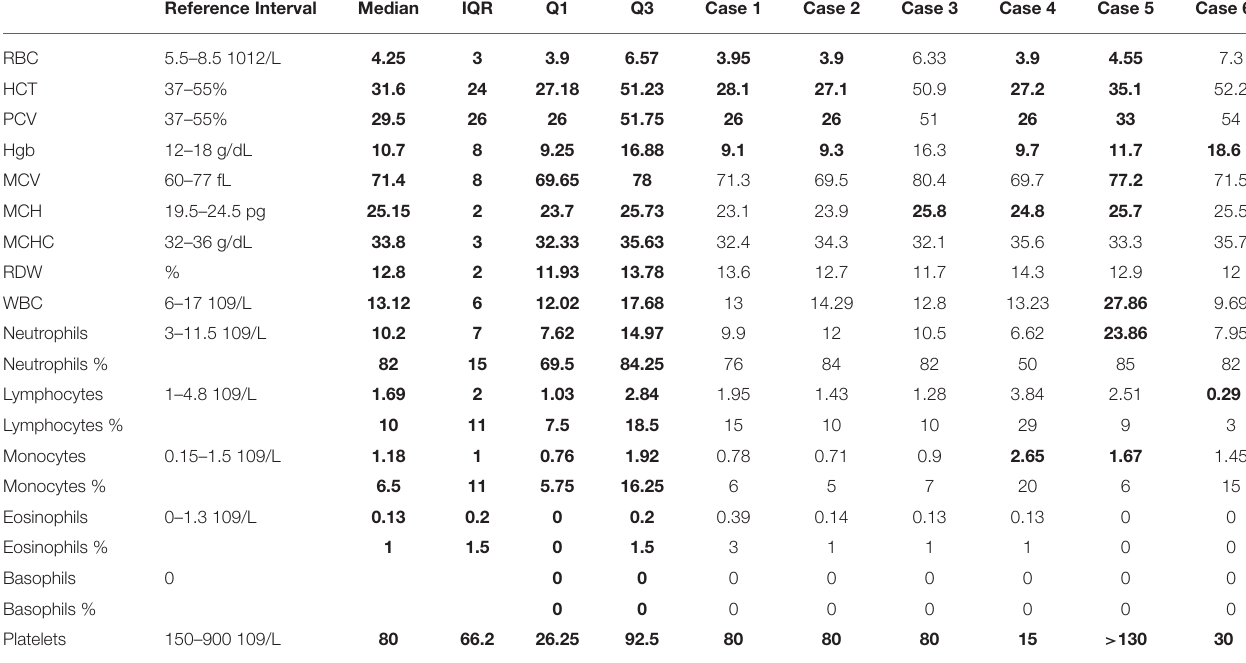
TABLE 2 | Hematology analysis performed on admission in six dogs with cutaneous and renal glomerular vasculopathy at the tertiary referral